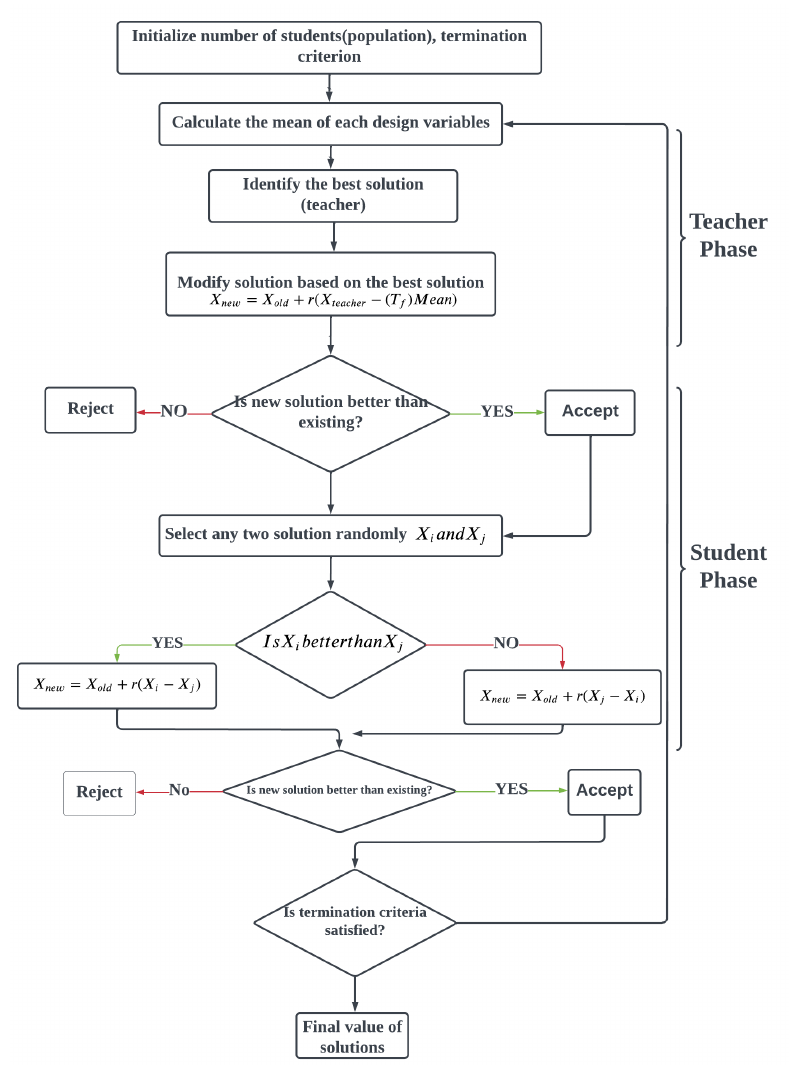
Figure 2. Flow chart for Teaching–Learning-Based Optimization